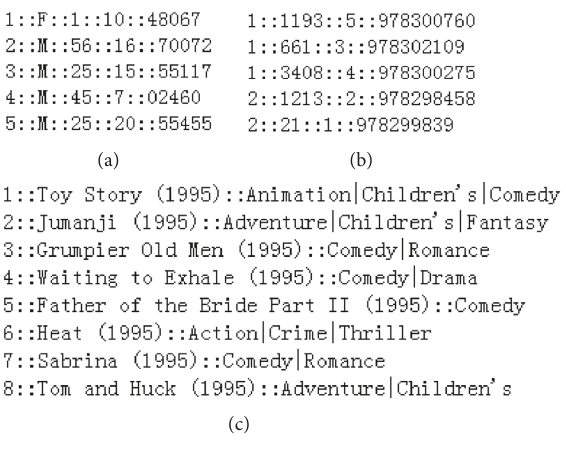
Figure 4: The samples of experimental